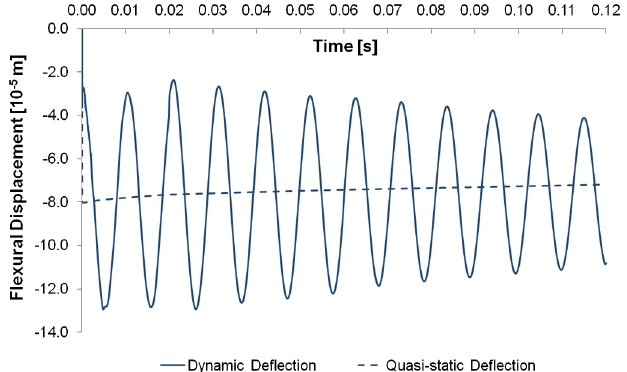
FIG. 21. Dynamic flexural displacement ( x -direction) of the collimator jaw assembly at z ¼ 0 . 42786 m, as provoked by the particle beam impact. The quasistatic deflection due to the thermal bending moment is also shown.